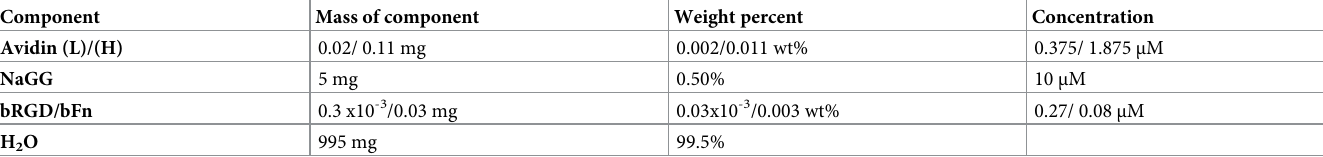
Table 1. Component concentration of hydrogel